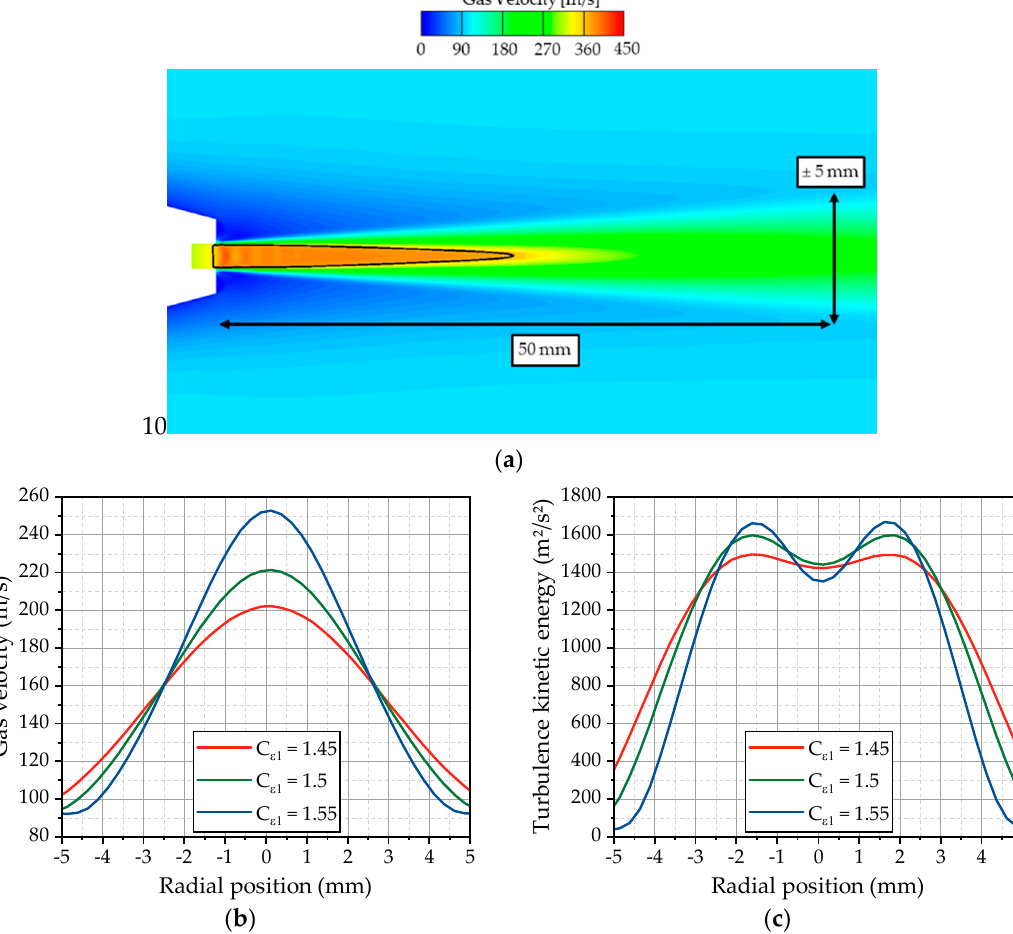
Figure 7. ( a ) Velocity of the gas jet and isoline with Ma = 1 (black line) for OP 2, with C ε 1 = 1.5 shown on a plane cut through the center line of the test rig. ( b ) Gas velocity and ( c ) turbulence kinetic energy over the radial position for the three selected parameters of the k ‐ε turbulence model for OP 2 at the first measurement position.